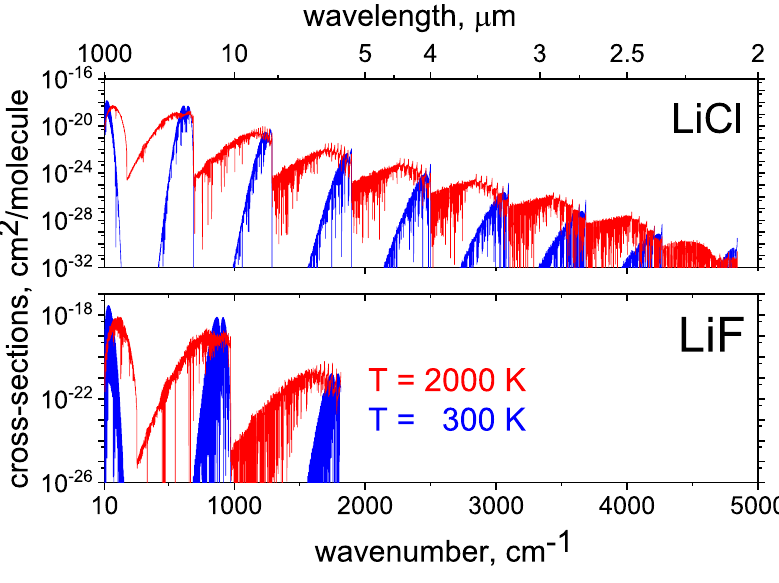
Figure 6. Absorption cross sections of LiCl and LiF from Bittner and Bernath